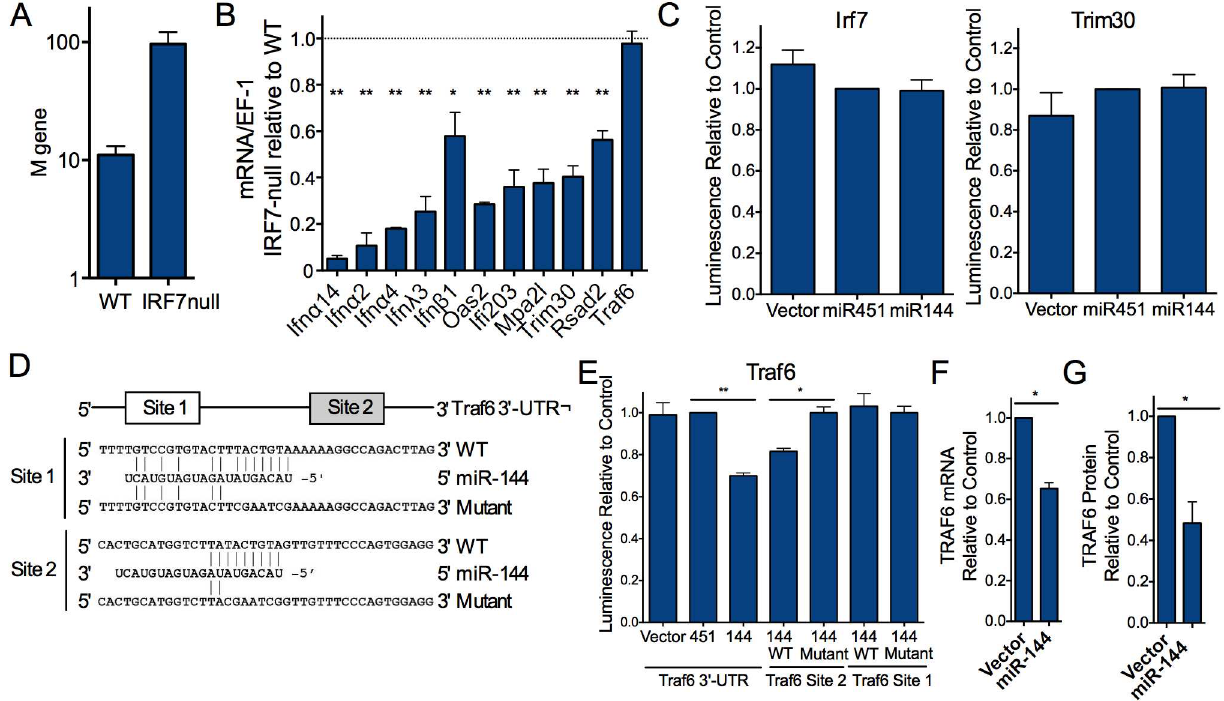
Fig 4. miR-144 negatively regulates IRF7 activity and TRAF6 expression. ( A ) Viral loadin the BAL of WT or IRF7 -/- mice infected with influenzavirus was quantifiedby qRT-PCR after 24 h. n = 3 mice per genotype. ( B ) Gene expressionin WT or IRF7 -/- mouse lungs following infection with influenzavirus for 24 h was measuredby qRT-PCR. Mean expression ± SEM in IRF7 -/- relative to wild-typemice is plotted. n = 3 mice per genotype. (C) Luminescence assay of cells expressingfirefly luciferase fused to the completecodingsequenceplus 3’-UTR of murine Irf7 or 3’-UTR only of Trim30 and miR-144, miR-451, or vector alone. Firefly/Renilla luminescence relative to cells expressingmiR-451 for 4 independentexperiments performed in triplicate are plotted (means ± SEM). Concordant results were obtained in TC-1 lung epithelial cells. ( D ) Sequencesof the 2 computationally predicted miR-144target sequencesin the Traf6 3’-UTR and the mutant target sequencesused for the experiments shown in E . ( E )Luciferaseassays wereperformedas in C usingfirefly luciferasefused to the complete3’-UTR of murine Traf6 or the intact or mutant miR-144target sites in the Traf6 3’-UTRshown in D . Means ± SEMfor 5 (completeUTR) or 3 (individualmiR-144 sites) independentexperiments performedin triplicateare shown. * p = 0.014, ** p= 0.010. ( F ) Reduced TRAF6 mRNA expression in influenza virus-infected TC-1 cells expressing miR-144 comparedto those expressing vector alone by qRT-PCR. Means ± SEMfor 3 independent experiments are shown, * p < 0.05.( G ) Reduced TRAF6 proteinin TC-1 cells expressing miR-144comparedto those expressing miR-451or vector alone pre- or 6 h post-infection with influenzavirus. See S5D Fig for a representative immunoblot. Means ± SEM for 3 independent experiments are graphicallydisplayed. * p < 0.05, ** p <